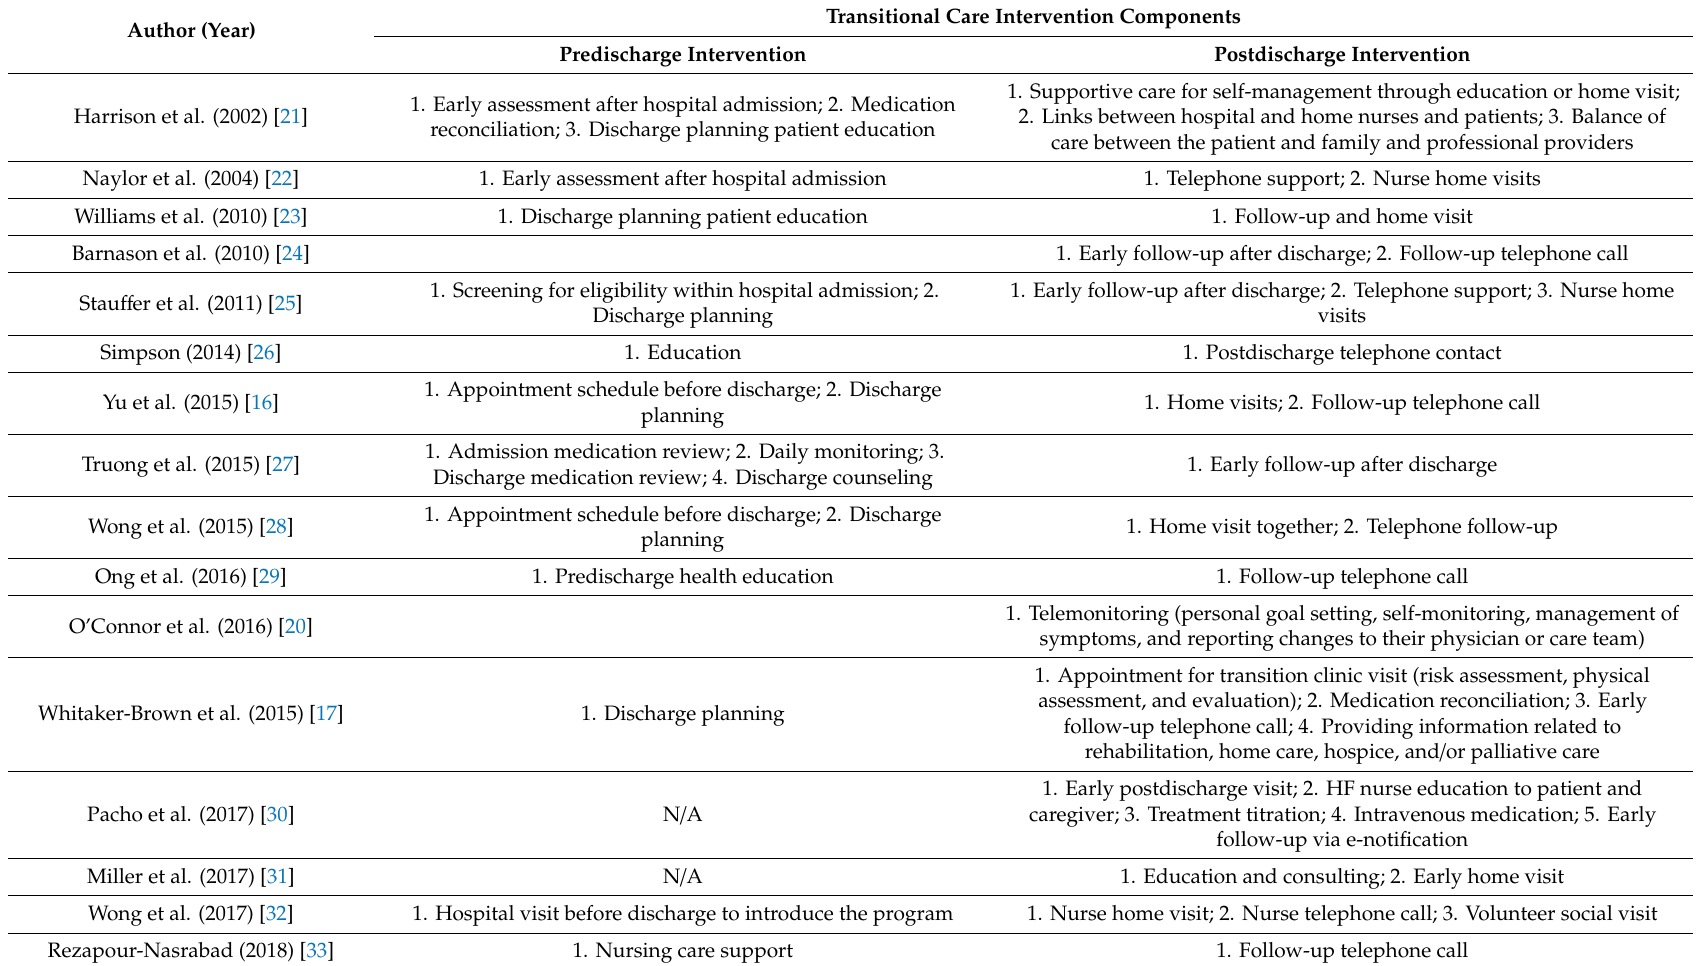
Table 2. Transitional care intervention components pre- and